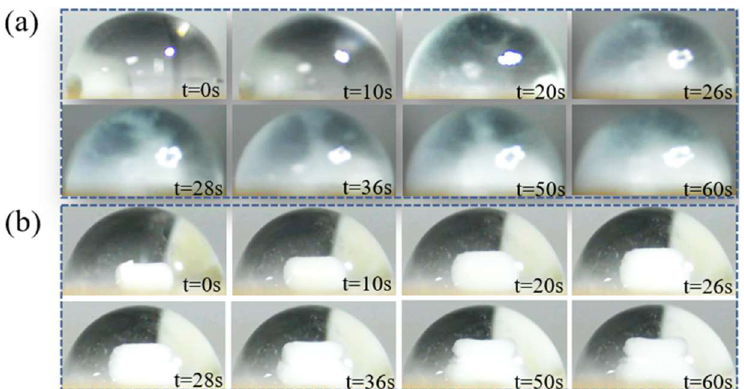
Figure 5. Effect of acoustic swirls on the dissolution of yeast cell powder granules. ( a ) When SAWs are ON, use the acoustic swirls to stir yeast cell powder granules for 60 s. ( b ) When SAWs are OFF, the changes of one yeast cell powder granules in stationary droplets for 60 s (as a control experi- ment).